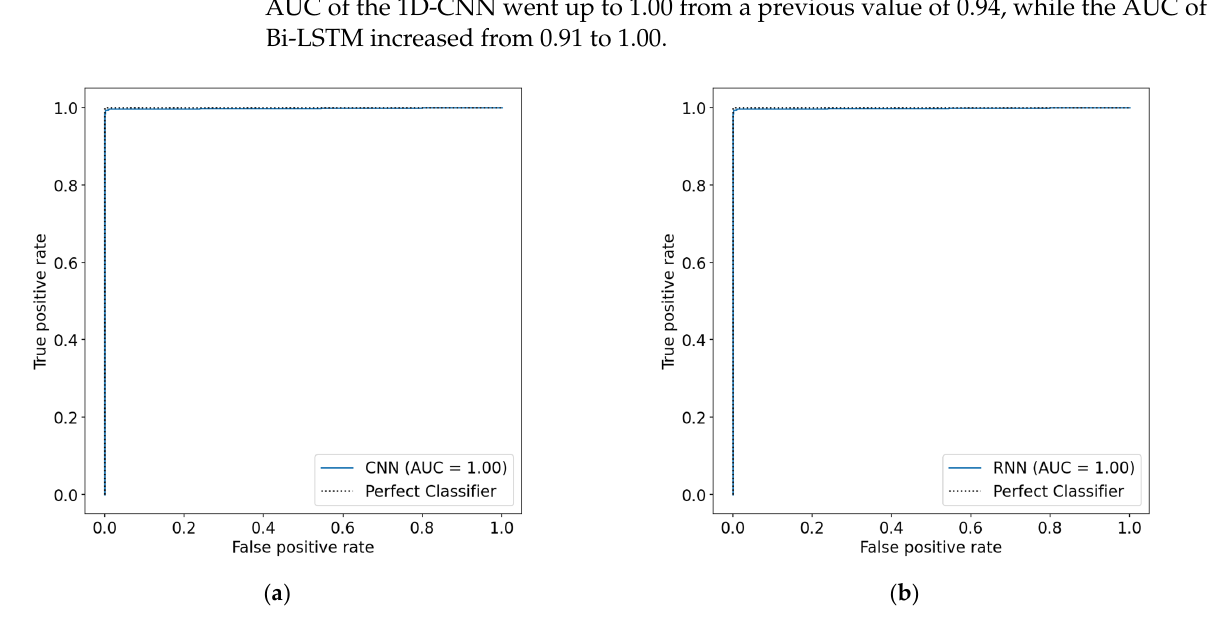
Bi-LSTM models performed better than both the SVM and ANN models. Table 8. Benchmarking the proposed models against ML and DL models for the Cleveland dataset.